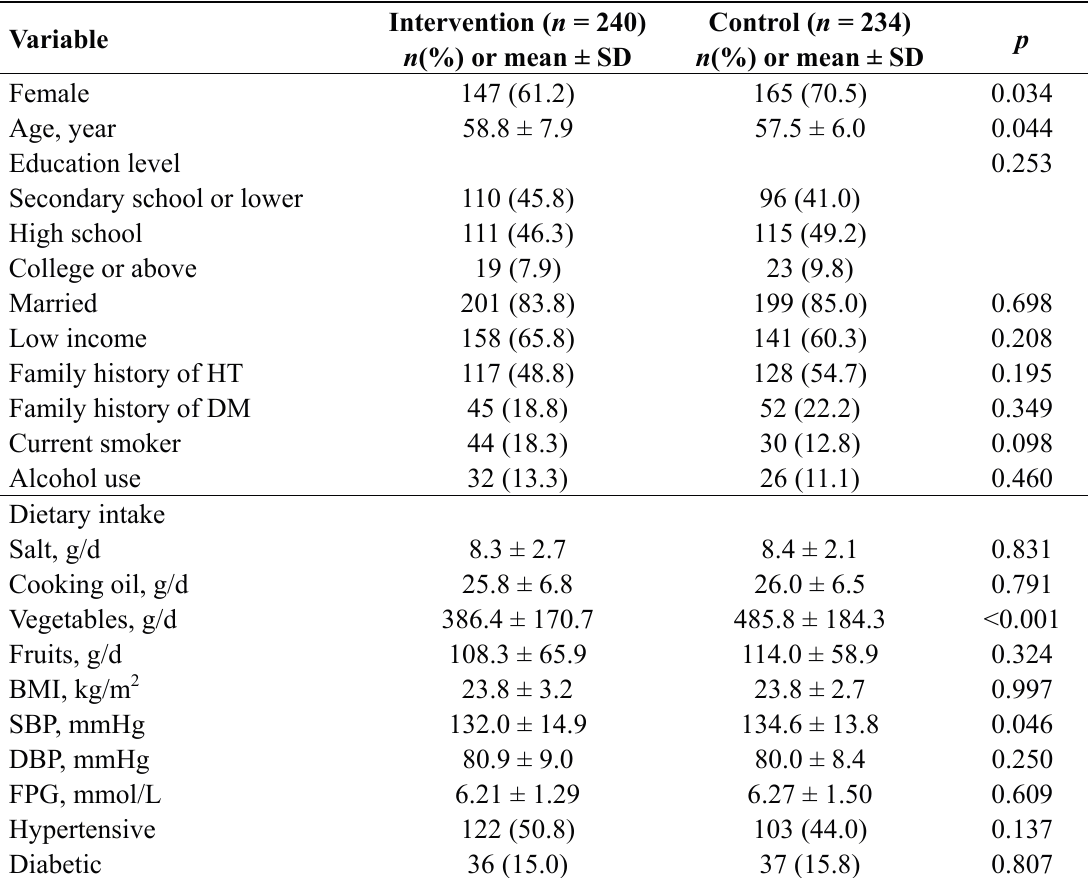
Table 2. Demographic and baseline characteristics of the